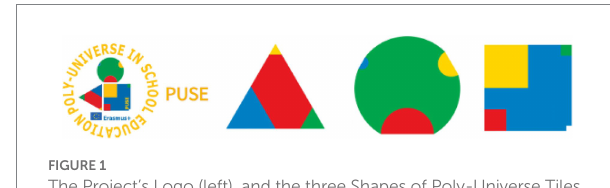
FIGURE 1 The Project’s Logo (left), and the three Shapes of Poly-Universe Tiles (left) (Saxon,